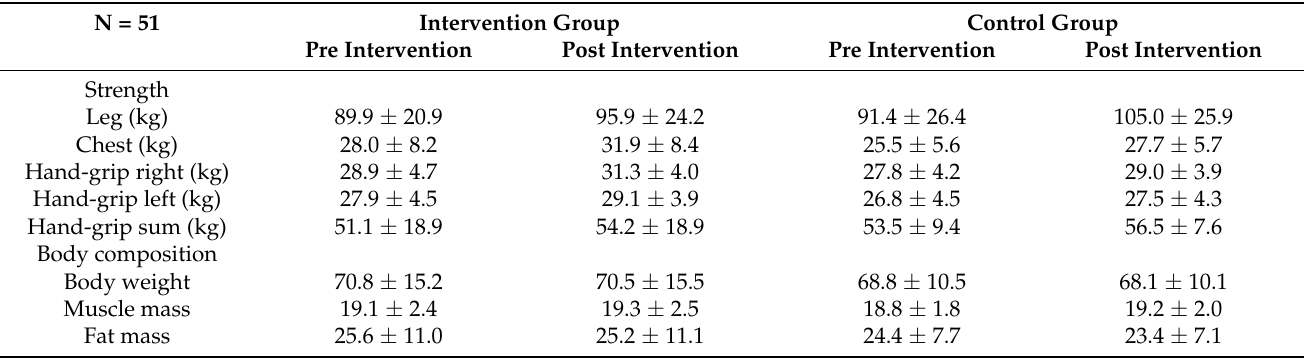
Table 3. Strength parameters and body composition showing the mean and standard deviation— Study